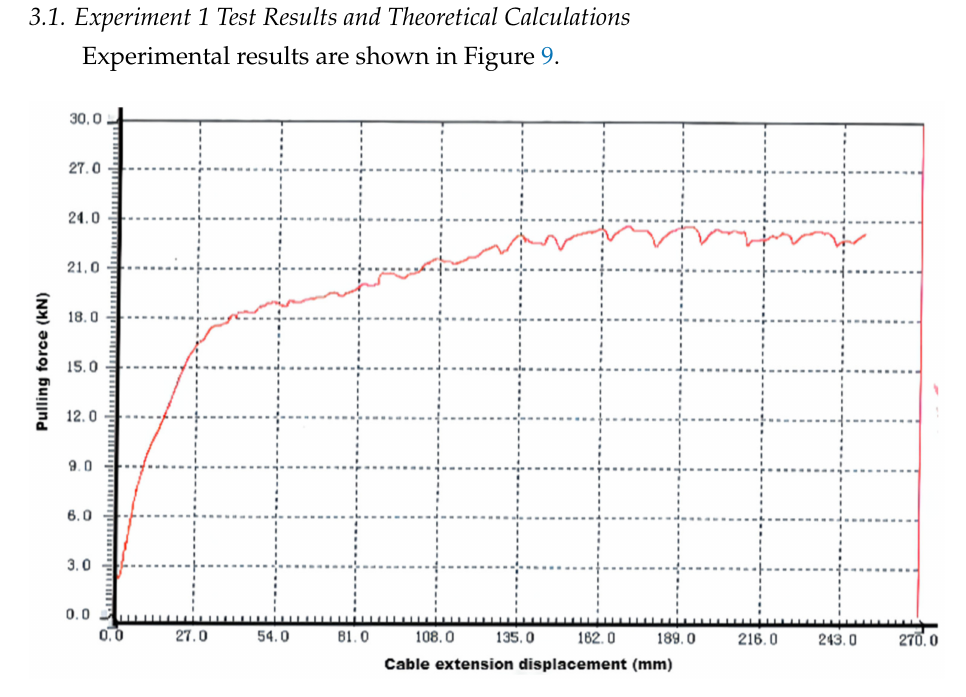
Figure 9. Tensile force–displacement result of Experiment 1. Abscissa represents cable conductor displacement (mm), and ordinate represents applied tensile force